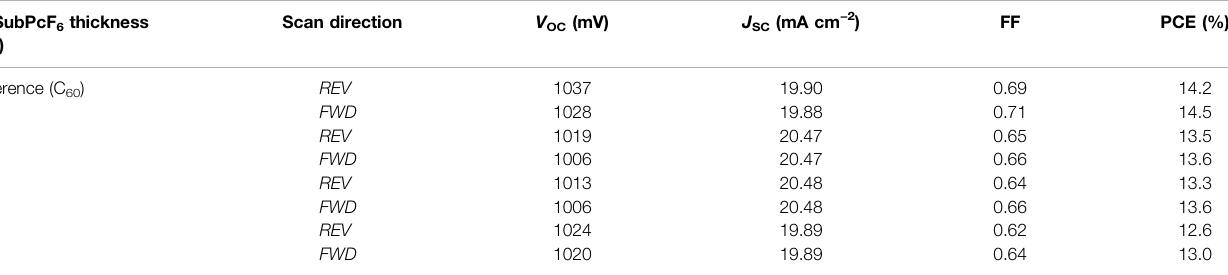
TABLE 2 | PV parameters of the most ef fi cient devices extracted from the corresponding J – V curves. FWD : forward scan (from J SC to V OC ), REV : reverse scan (from V OC to J SC